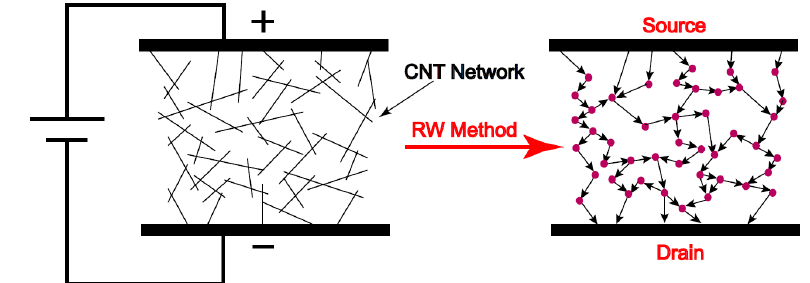
Figure 9. Schematic of random walk model approach for calculating the resistivity of a CNT network.